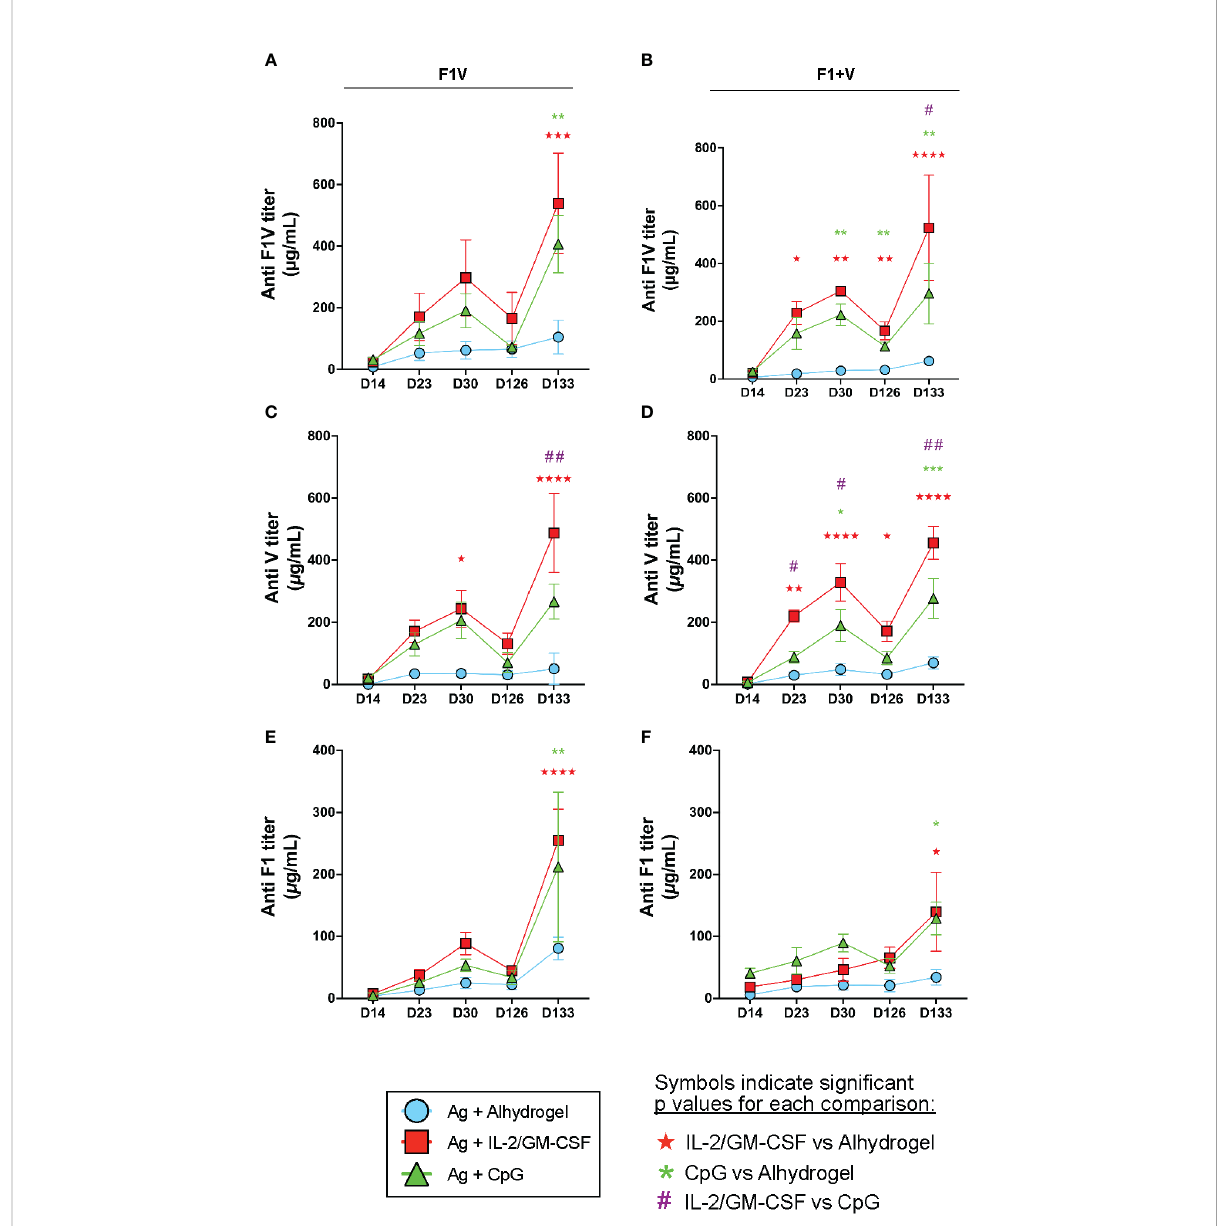
FIGURE 6 CpG and IL-2/GM-CSF as adjuvants drive increased long-lived antibodies against plague antigens. Mice were immunized on day 0 and given booster shots day 16. Remaining mice were challenged with 10 m g of F1V antigen on d126. Serum was collected on day 14, 23, 30, 126 and 133 for antibody titer analysis. Mean serum IgG titers of F1V antigen groups are shown for F1V (A) , V (C) and F1 (E) . Mean serum IgG titers of F1+V antigen groups are shown for F1V (B) , V (D) , F1 (F) . n=5 per group per experiment at each time point. Data shown are from one experiment and are representative of two independent experiments. Statistically signi fi cant p values were determined using Two-way ANOVA; Colored symbols (red star, green asterisk, or purple hashtag) indicate signi fi cant p values for each of the indicated comparisons between experimental groups: one symbol for p < 0.05, two symbols for p < 0.01, three symbols for p < 0.001, and four symbols for p <